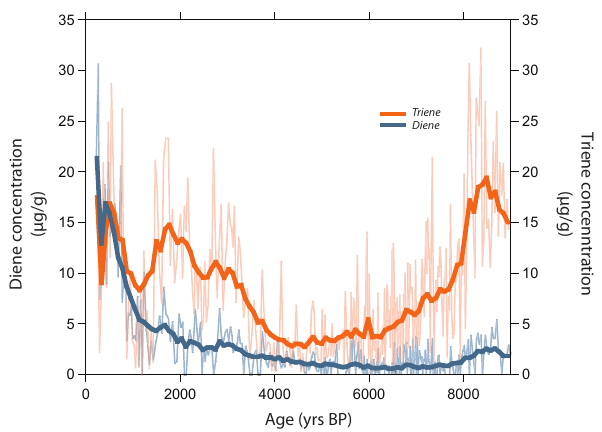
Fig. 5. Holocene diene (blue) and triene (orange) concentrations and their respective smoothed curves at the JPC-10 core